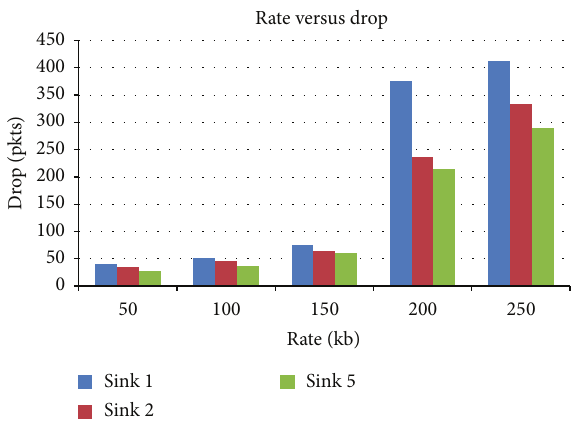
Figure 11: Rate versus overhead in terms of sink.